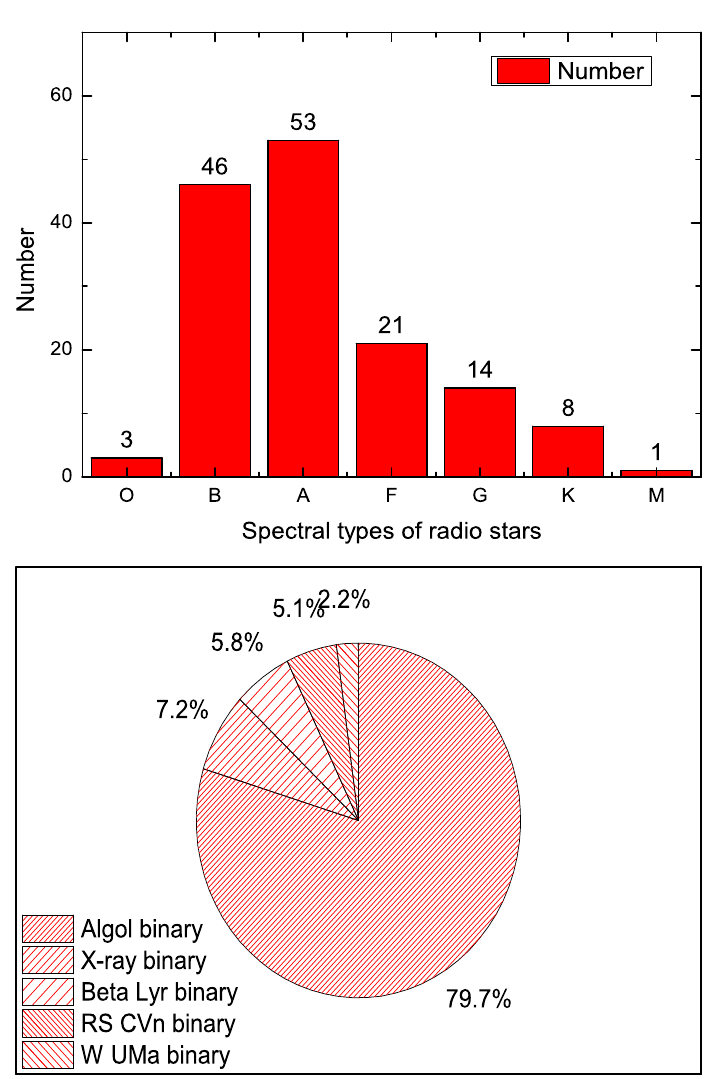
Figure 1. The number distribution of 152 radio eclipsing binaries, where the top panel is the distri- bution of their spectral types, and the bottom panel is the distribution of the percentage of types of radio